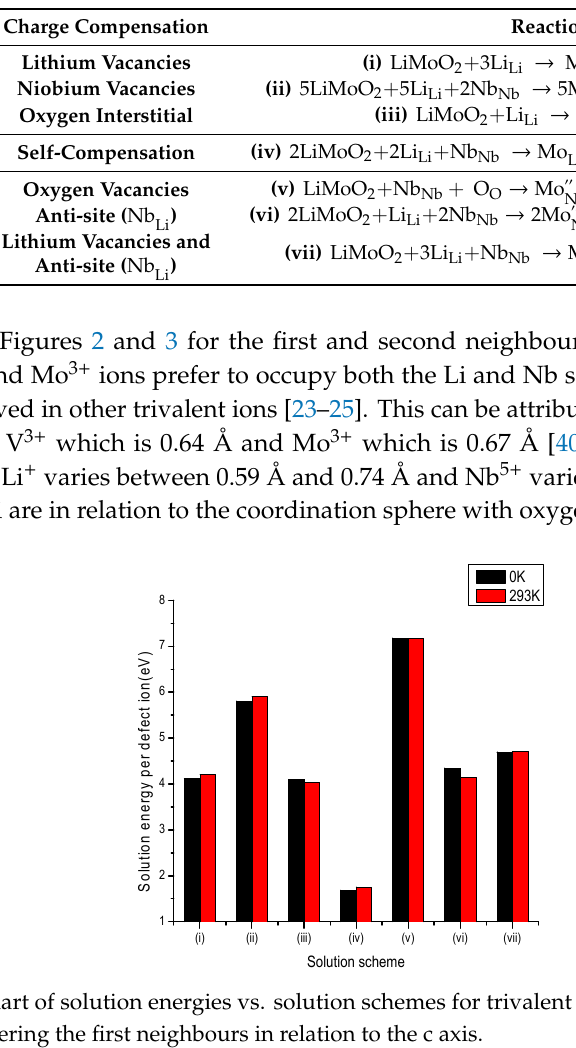
Figure 3. Bar chart of solution energies vs. solution schemes for trivalent dopant (Mo 3+ ) at the Li and Nb sites, considering the first neighbours in relation to the c axis. 3.2.3. Tetravalent Dopants Like other divalent and trivalent cations, tetravalent V 4+ and M 4+ dopant ions can also substitute at either the Li + or Nb 5+ sites. When these ions substitute at the Li + and Nb 5+ site charge compensation is required, and various schemes involving vacancies, interstitials, anti-sites and self-compensation are adopted, as shown in Tables 6 and 7. Table 6. Types of defects considered due to M = V 4+ incorporation in LiNbO 3 . Site